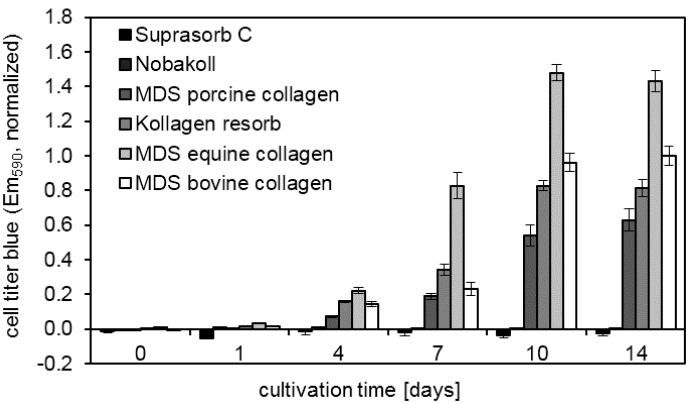
Figure 5. CellTiter-Blue assay indicates changes in metabolic activity up to two weeks after NIH 3T3 fibroblast seeding on different types of collagen disks.